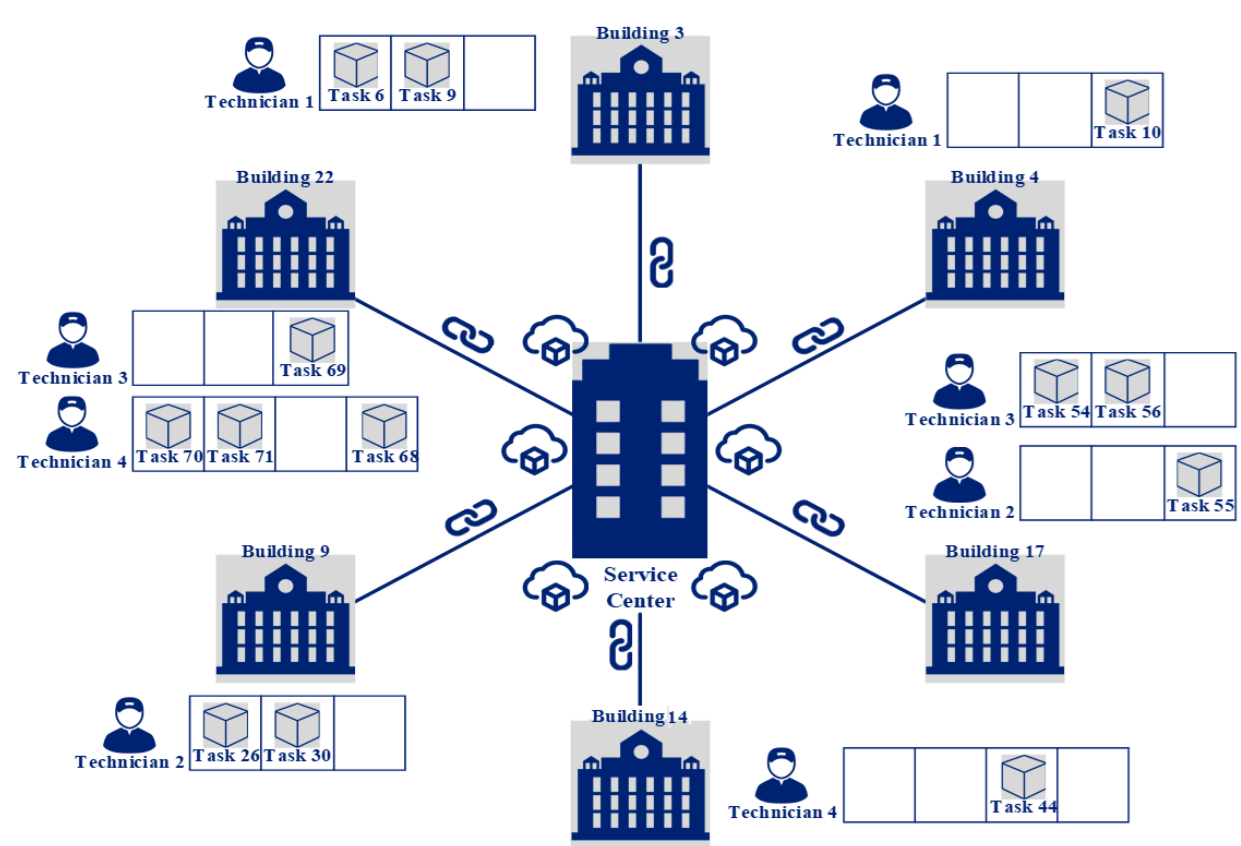
Figure 12. The sequencing process for service tasks by technicians in day 1. Table 11. The distribution of tasks for technicians in days 7 to 12. Day